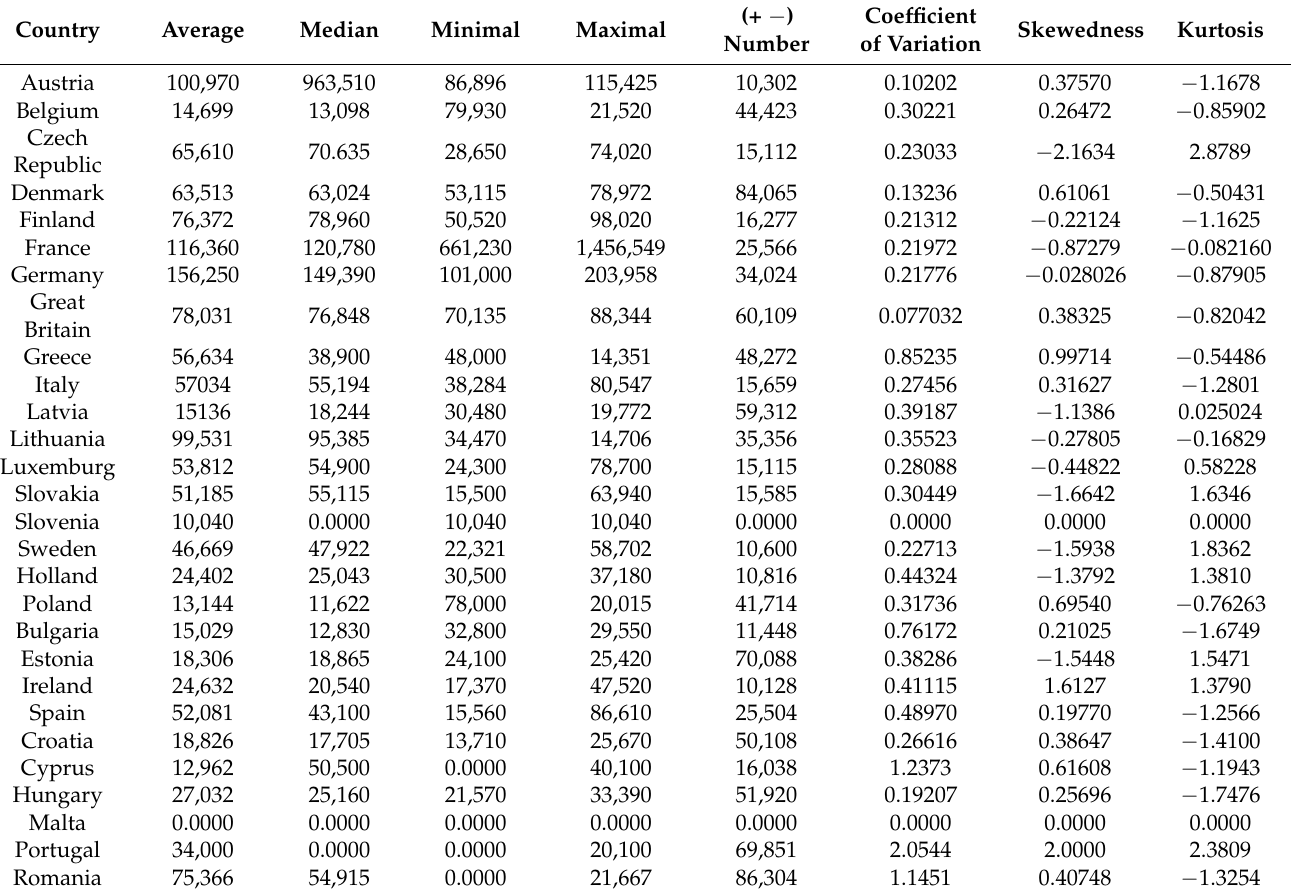
Table 1. Descriptive statistics of cows in organic farms in the